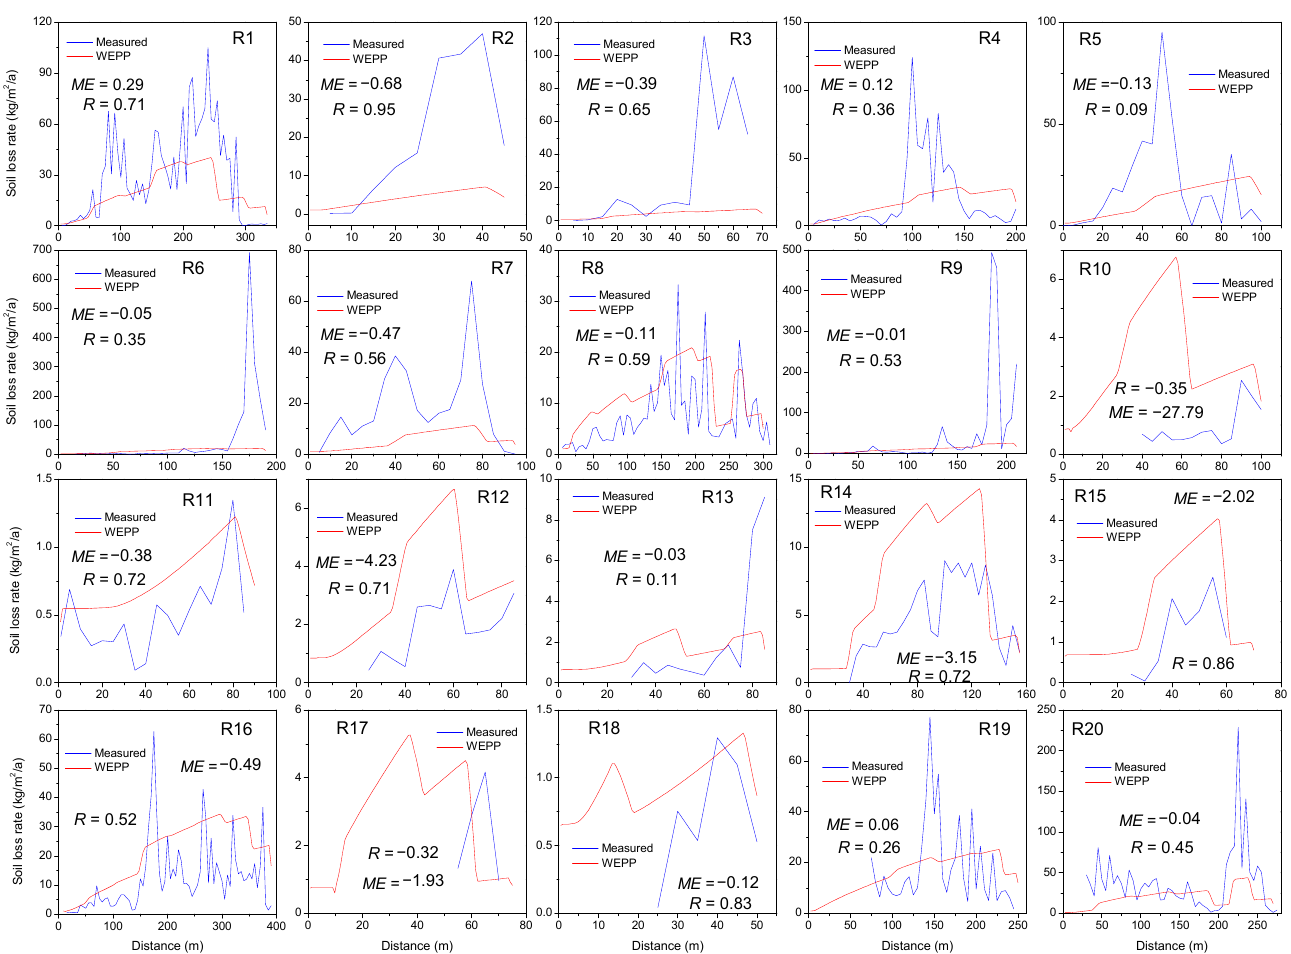
Figure 4. The TLS-measured and WEPP-predicted detailed soil loss along road segments. Figure 4. The TLS ‐ measured and WEPP ‐ predicted detailed soil loss along road segments. A consistent trend could also be found from the peak values. Although the simulated Table 3. TLS ‐ measured soil loss as a function of WEPP ‐ predicted soil loss along roads. values generally underestimated the peak soil loss rate in most cases, the positions of the peak soil loss along road segments could be simulated by the WEPP. As illustrated